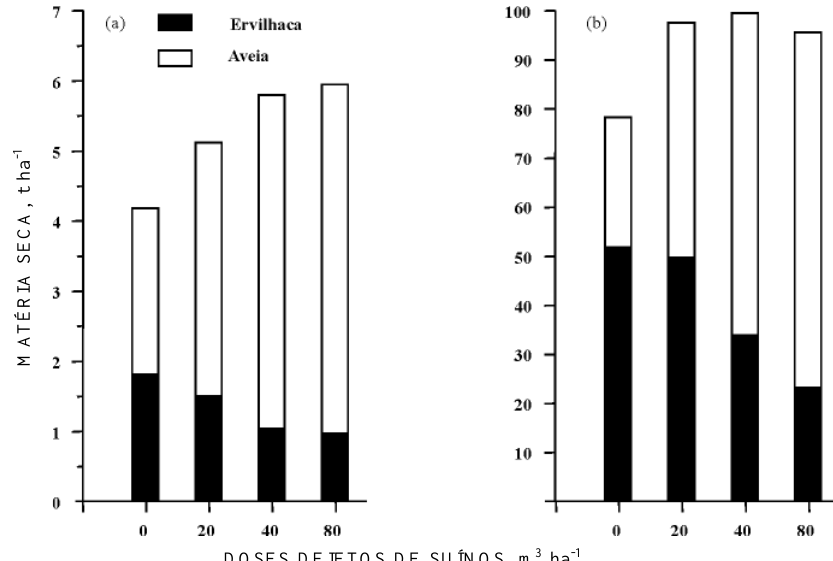
Figura 4. Produção de matéria seca (a) e acúmulo de nitrogênio (b) pela aveia e pela ervilhaca quando consorciadas e adubadas com doses crescentes de dejetos de